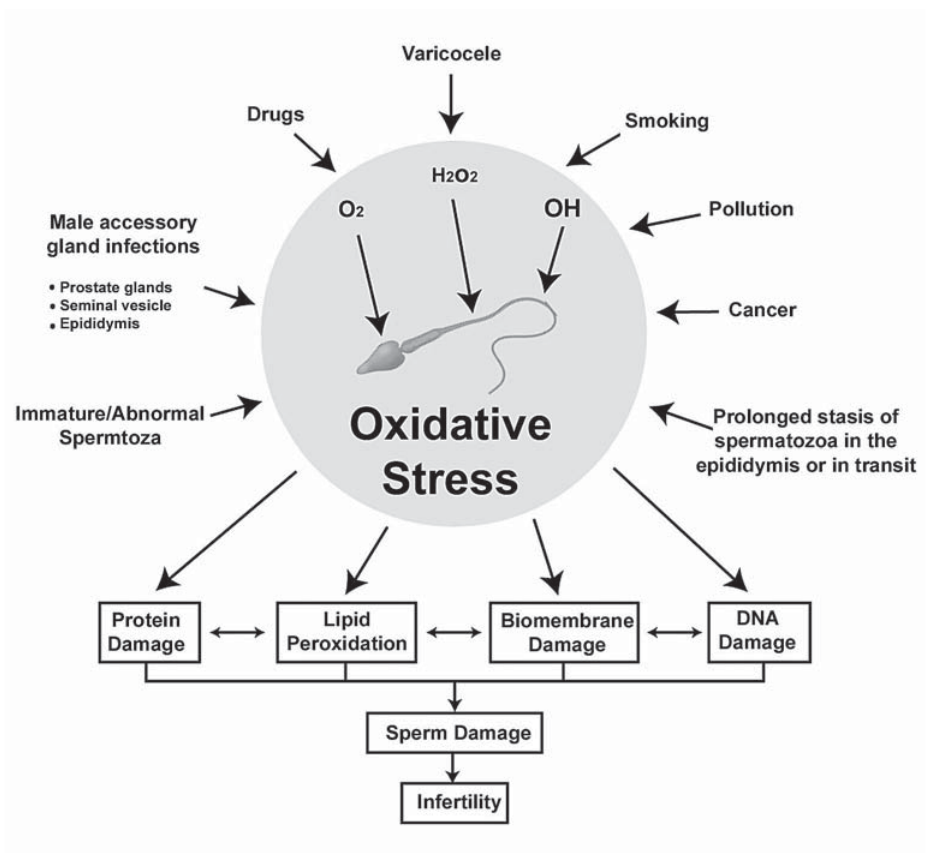
Figure 1 – Association of increasing reactive oxygen species (ROS) production with